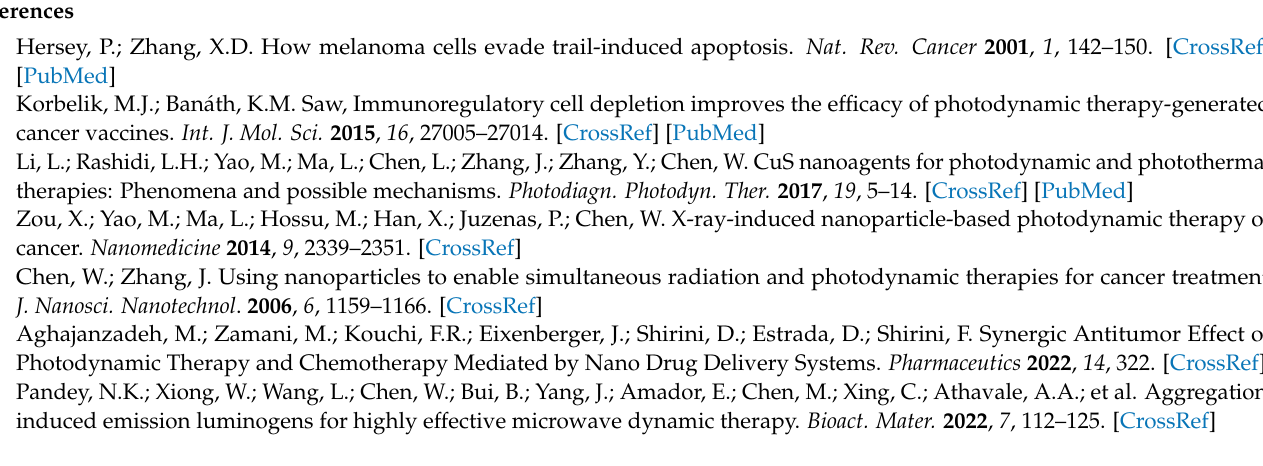
Figure S3: Zoom, at different spectral ranges, of the SERS spectra of SLN-AlPc formulation (black lines) and physical mixture (AlPc + SLN), (red lines) of samples (i) Gly-solution (ii) 2Gly@PEG/NPs, and (iv) normal Raman spectrum of Gly-solution. Figure S4: Fluorescence (A e B) and absorbance (C) spectrum of SLN-AlPc. A = Ex:660 nm and B = Ex:350 nm. Table S1: Stability of SLN-AlPc by